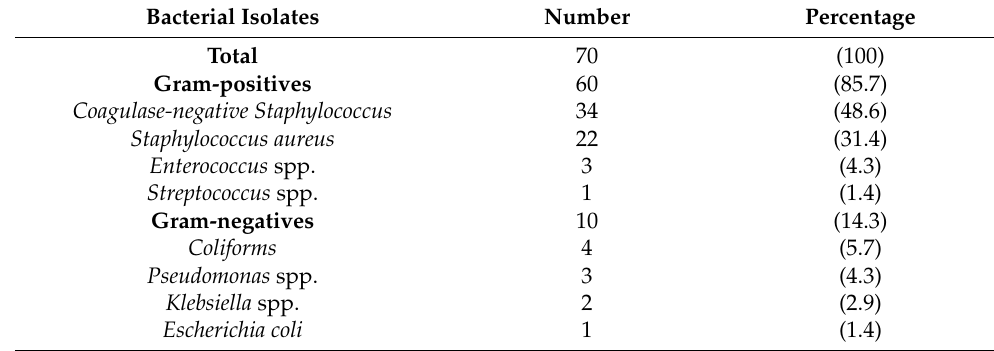
Table 6. Bacterial isolates from blood samples of culture-positive neonates admitted with suspected sepsis at Komfo Anokye Teaching Hospital, Ghana, between January 2021 and December